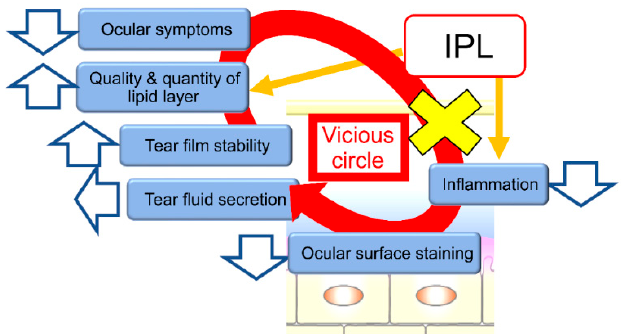
Figure 2. Proposed mechanism of action of IPL therapy on the vicious cycle of dry eye. IPL increases the quality and quantity of the lipid layer of the tear film as well as reduces inflammation of the ocular surface and lid margin. These effects result in amelioration of ocular surface epitheliopathy (ocular surface staining) and an increase in tear film stability, followed by improvement of ocular symptoms without any change in tear fluid secretion. IPL can block the vicious cycle (yellow x) underlying the pathophysiology of dry eye. IPL, Intense pulsed light